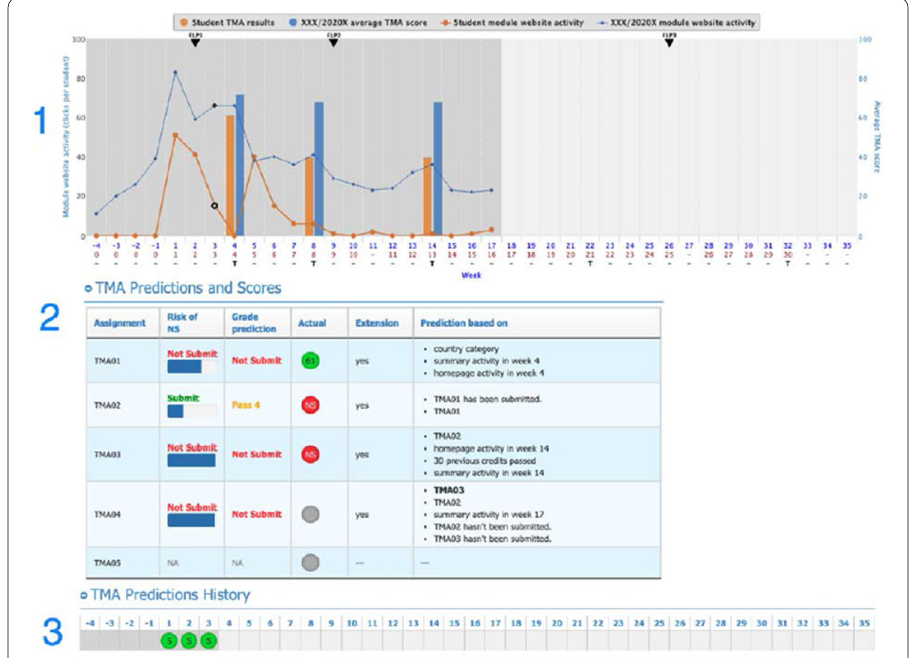
Fig. 2 Student view of the LAD used in this study—VLE engagement and